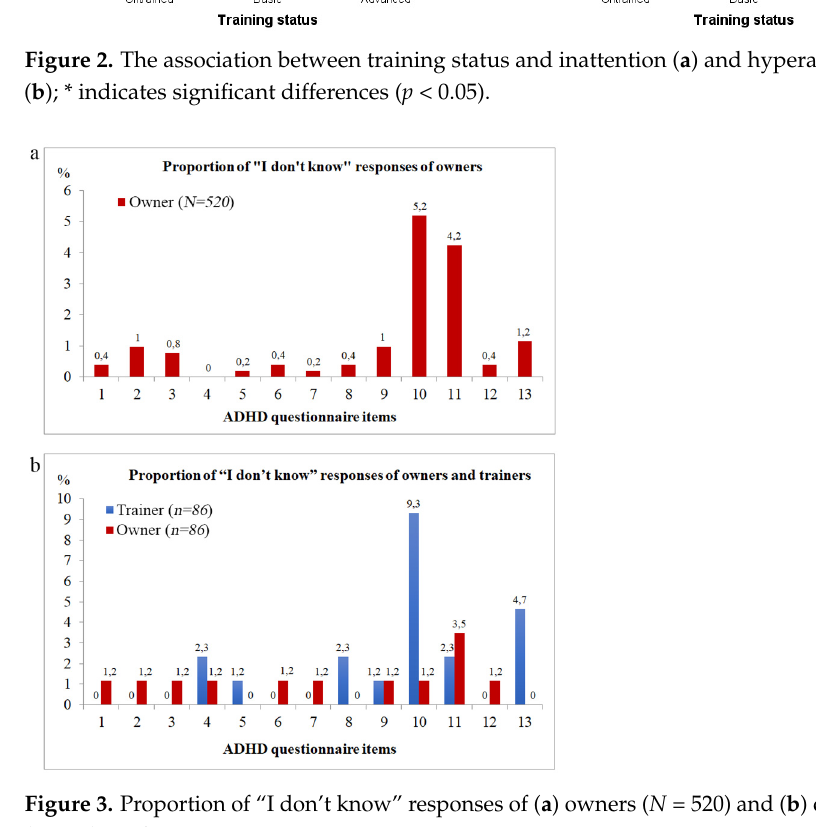
Figure 3. Proportion of “I don’t know” responses of ( a ) owners ( N = 520) and ( b ) owners and train- ers ( n = 86) on the Dog ARS IDK. ( n = 86) on the Dog ARS